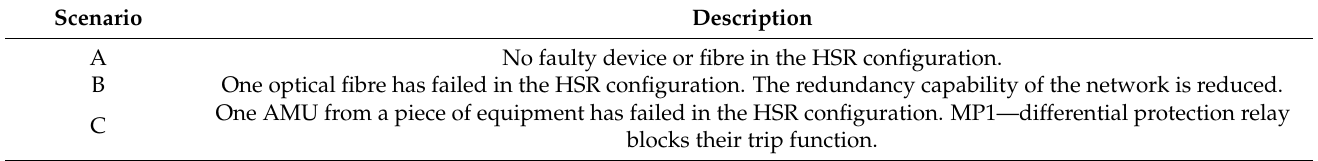
Table 2. Intentional faults applied to communication infrastructure for HSR configuration.